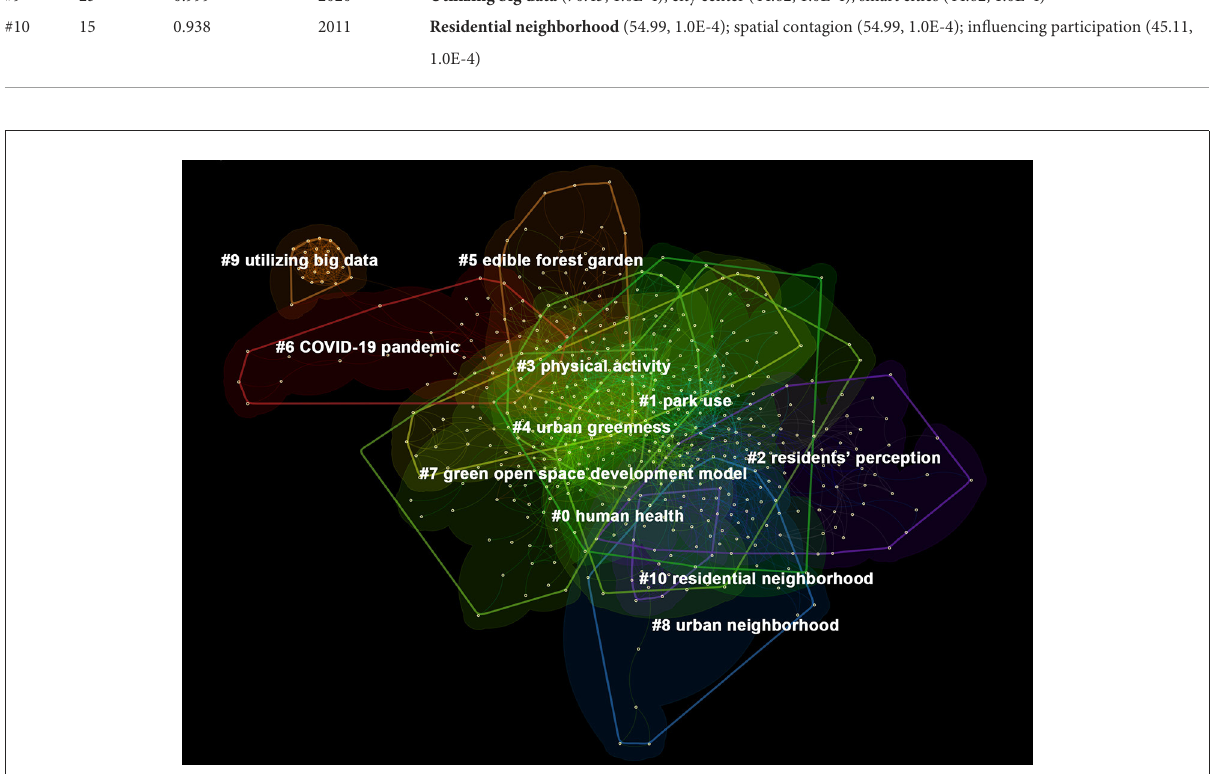
FIGURE5 Knowledge map of co-cited reference